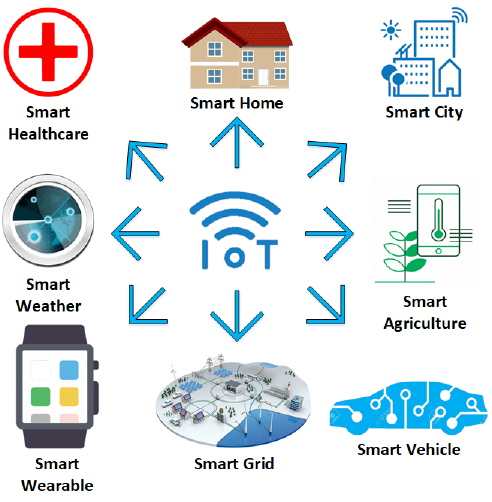
Figure 1. IoT Applications in Various